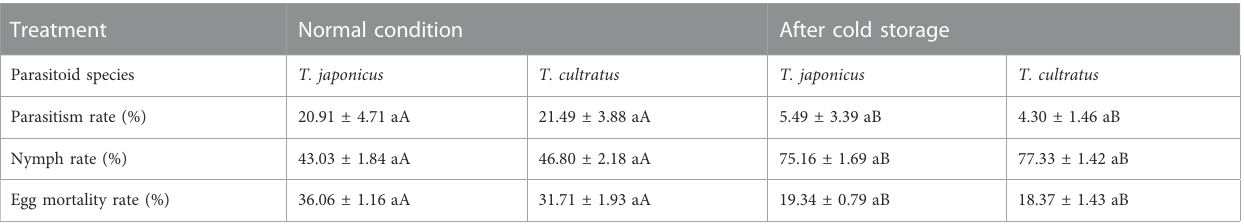
TABLE 1 Parameters for T. japonicus and T. cultratus when reared under normal conditions (25 ° C) and after a cold storage period of 19 weeks at constant 11 ° C. Treatment Normal condition